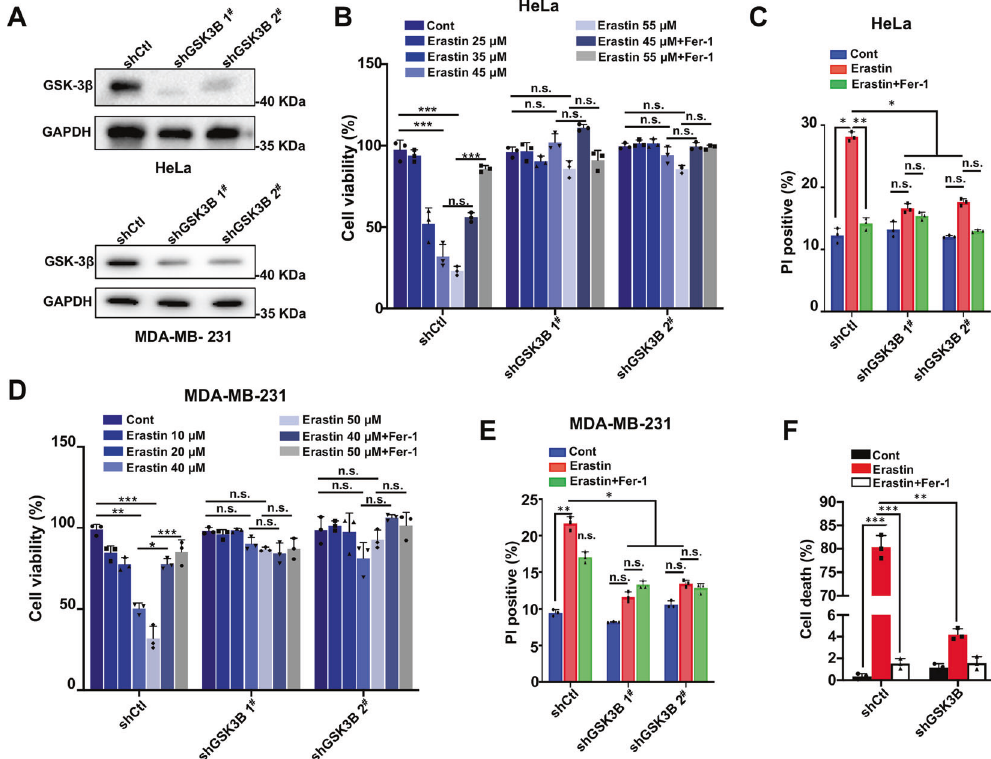
Fig. 2 GSK-3 β knockdown suppresses erastin-induced ferroptosis. A Western blot analysis of GSK-3 β expression indicated GSK-3 β knockdown (KD) in HeLa and MDA-MB-231cells using two speci fi c short hairpin RNAs (shRNAs) (referred to shGSK-3 β 1 # and 2 # ). Independent experiments are repeated three times and the shown is a representative image. B Indicated HeLa cells were treated with erastin (0, 25, 35, 45, and 55 μ M) in combination with or without 20 μ M Fer-1 for 24 h, cell viability was assayed using CCK8 kit. C Indicated HeLa cells were treated with erastin (35 μ M) alone or with Fer-1 (20 μ M) for 24 h, and cell death was measured by propidium iodide (PI) staining detected by fl ow cytometry. The percentage of the PI-positive cell population was analyzed using FlowJo software (Version 10.0). D Indicated MDA-MB-231 cells were treated with erastin (0, 10, 20, 40, and 50 μ M) in combination with or without 20 μ M Fer-1 for 24 h, and cell viability was assayed using a CCK8 kit. E Indicated MDA-MB-231 cells were treated with erastin (40 μ M) alone or with Fer-1 (20 μ M) for 24 h, and cell death was measured by propidium iodide (PI) staining detected by fl ow cytometry. The percentage of PI-positive cell population was analyzed using FlowJo software (Version 10.0). F Indicated HeLa cells were treated with erastin (35 μ M) alone or with Fer-1 (20 μ M), and cell death was measured by propidium iodide (PI) staining using fl uorescence microscopy. The percentage of PI-positive (red) cells were quantitated. Data shown represent mean ± SD from three independent experiments. Statistical analysis was made using Student ’ s t -test; * p < 0.05, ** p < 0.01, *** p <